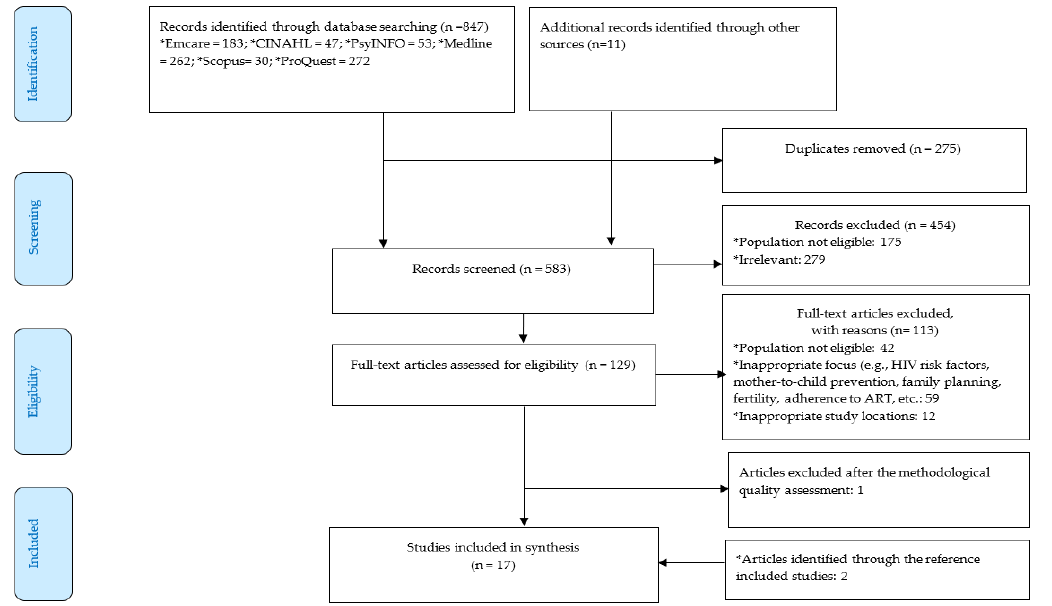
Figure 1. PRISMA Flow diagram of systematic literature search: records identified, screened, eligible and included in the review.